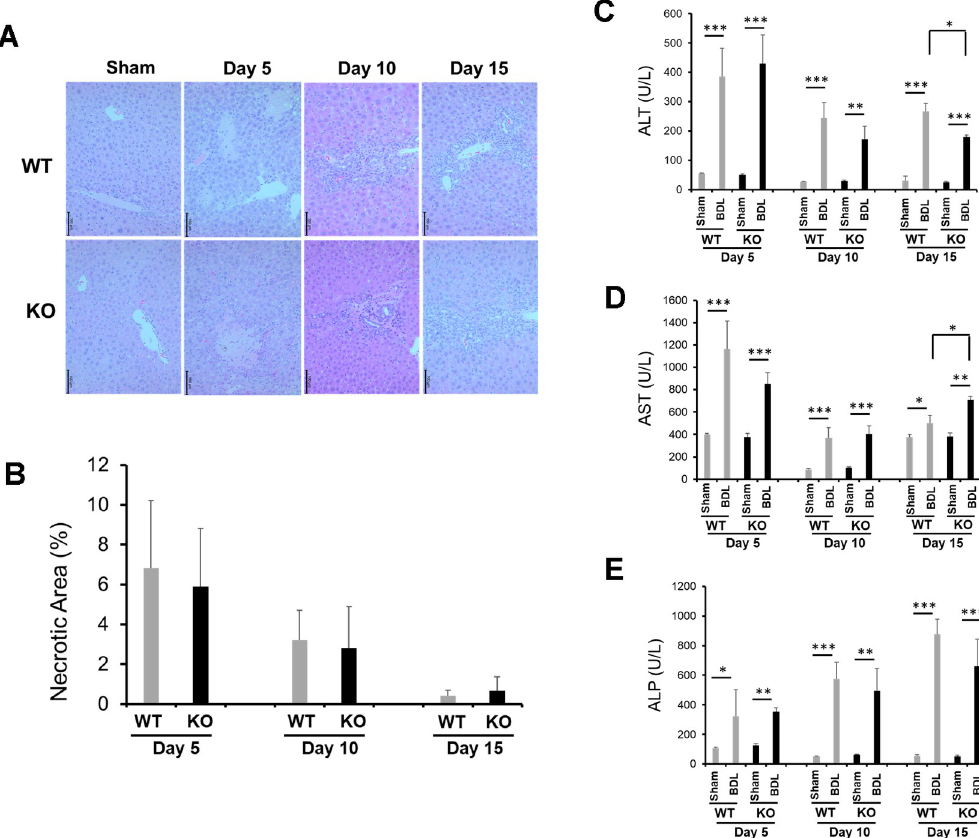
Fig 2. Liver injury in Nrf2 +/+ (WT) and Nrf2 -/- (KO) mice following bile duct ligation (BDL) or sham operation (Sham). Adult male mice of both genotypes underwent BDL or Sham. (A) Representative images of liver sections stained with H&E. (B) Percentage of necrosis area. Serum concentrations of (C) ALT, (D) AST, and (E) ALP were measured. Data are presented as mean ± SEM (n = 5). � P < 0.05; �� P < 0.01; ��� P < 0.001.